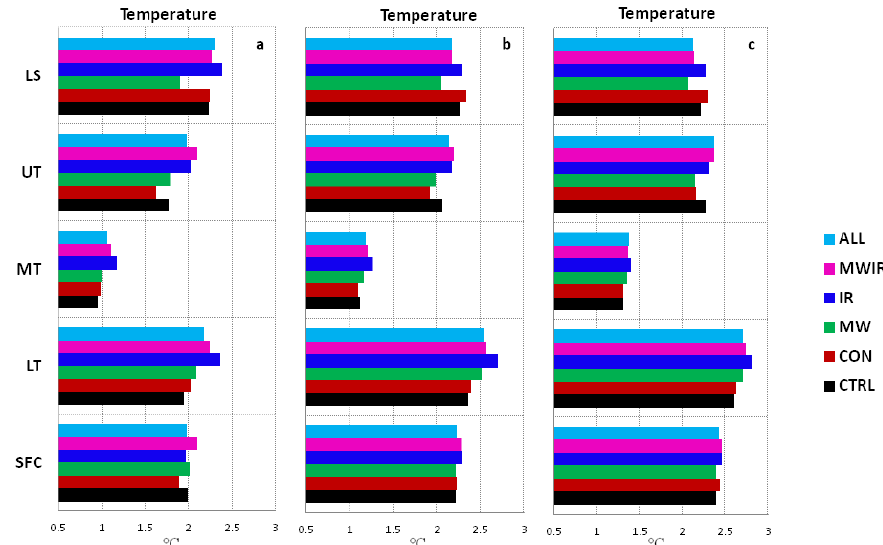
Figure 7. The RMSE profile of the temperature forecasts at (a) 6h , (b) 30h, (c) 54h forecasts. Unit: ◦ C. Other definitions are the same as in Fig.